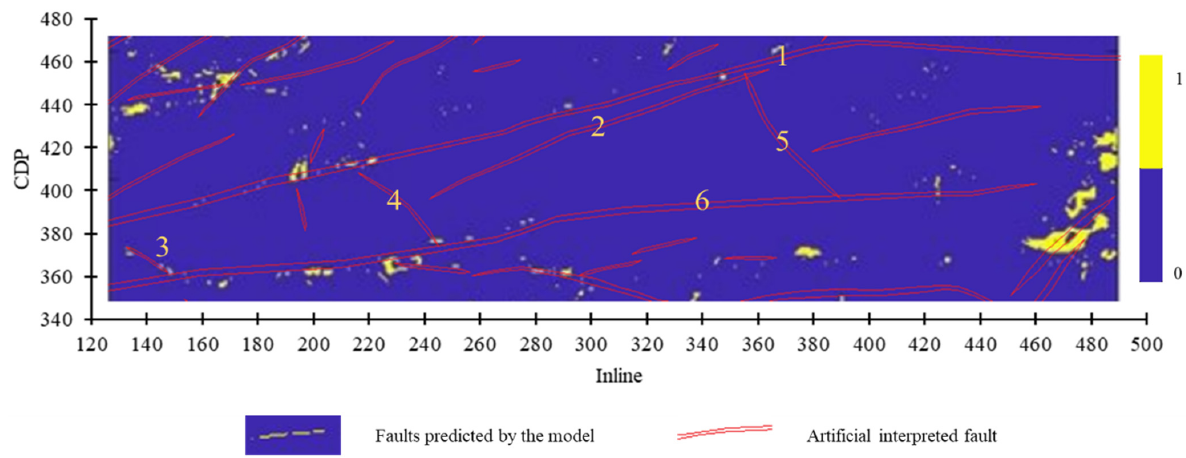
Figure 10. Prediction result of Model 1.